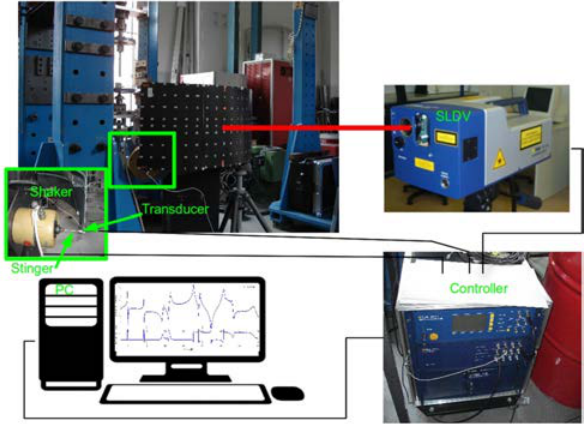
Figure 5: Experimental Set-up [11].